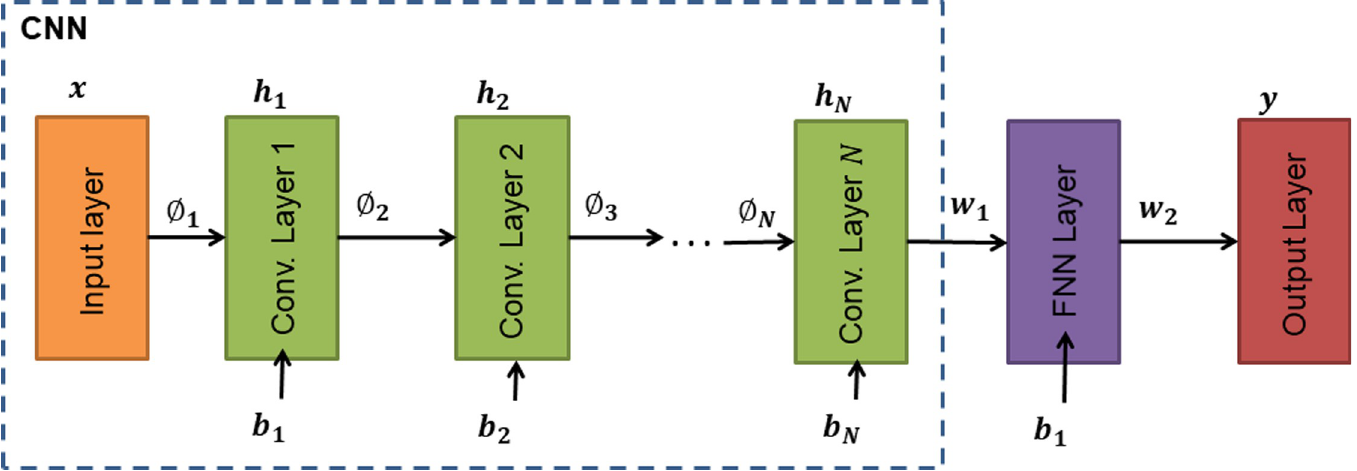
Fig 4. CNN design architecture.